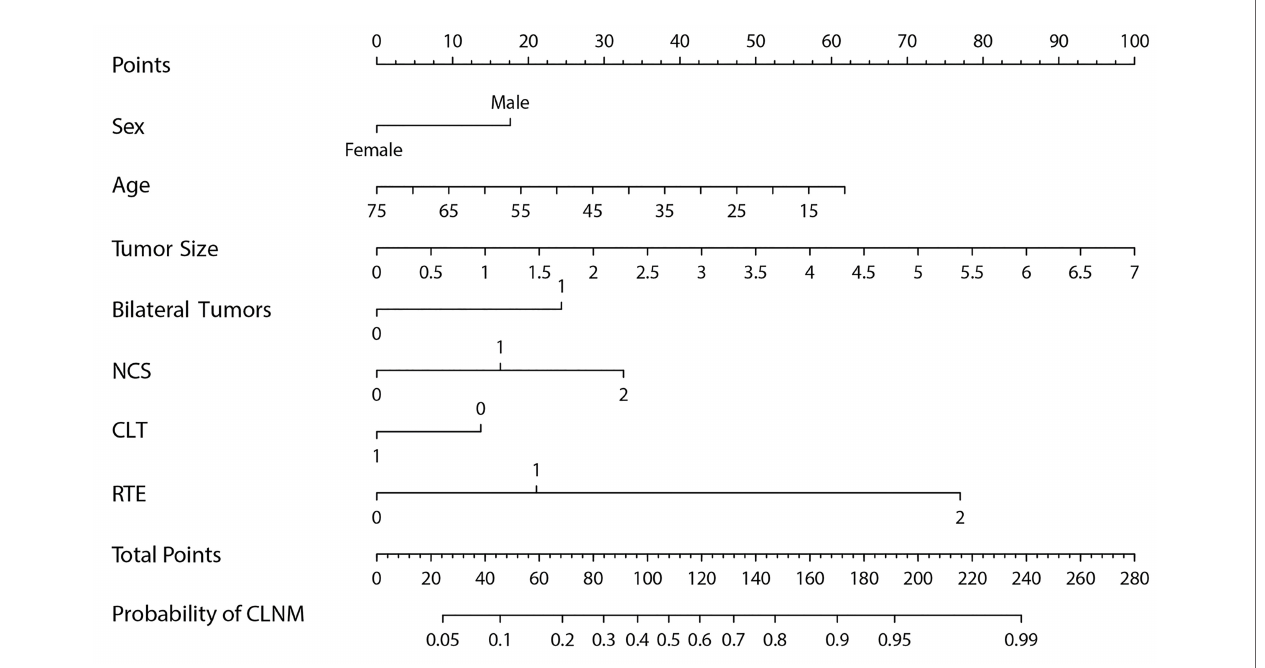
FIGURE 4 | The nomogram of model 1 for predicting the risk of CLNM in cN0 PTC.